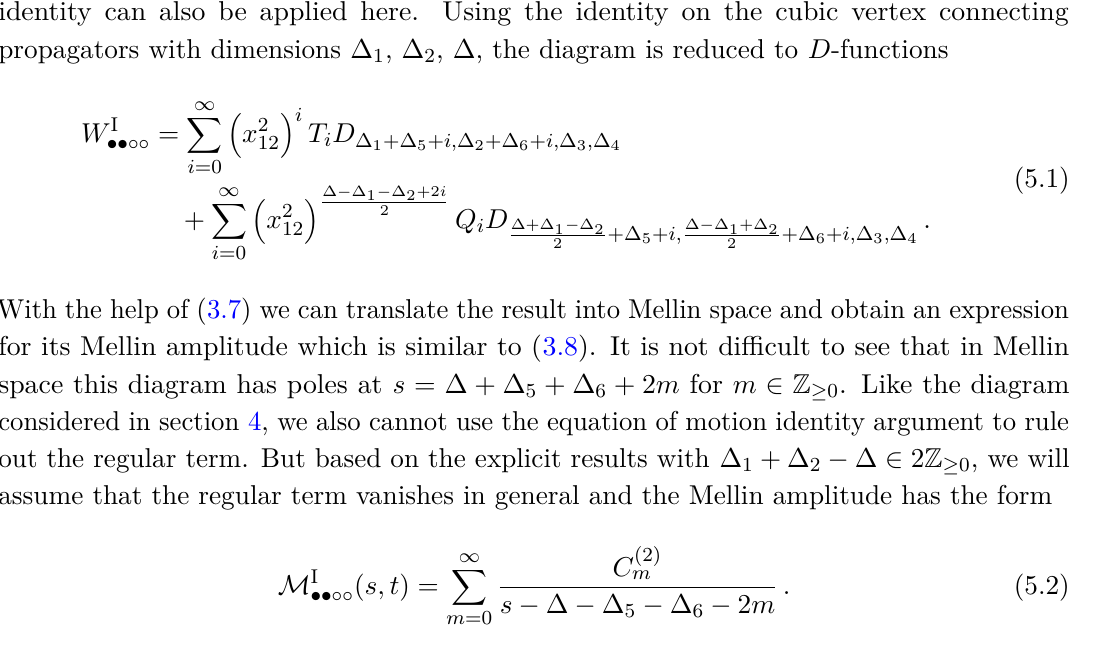
Figure 7 . Exchange Witten diagram with two bound states (Type